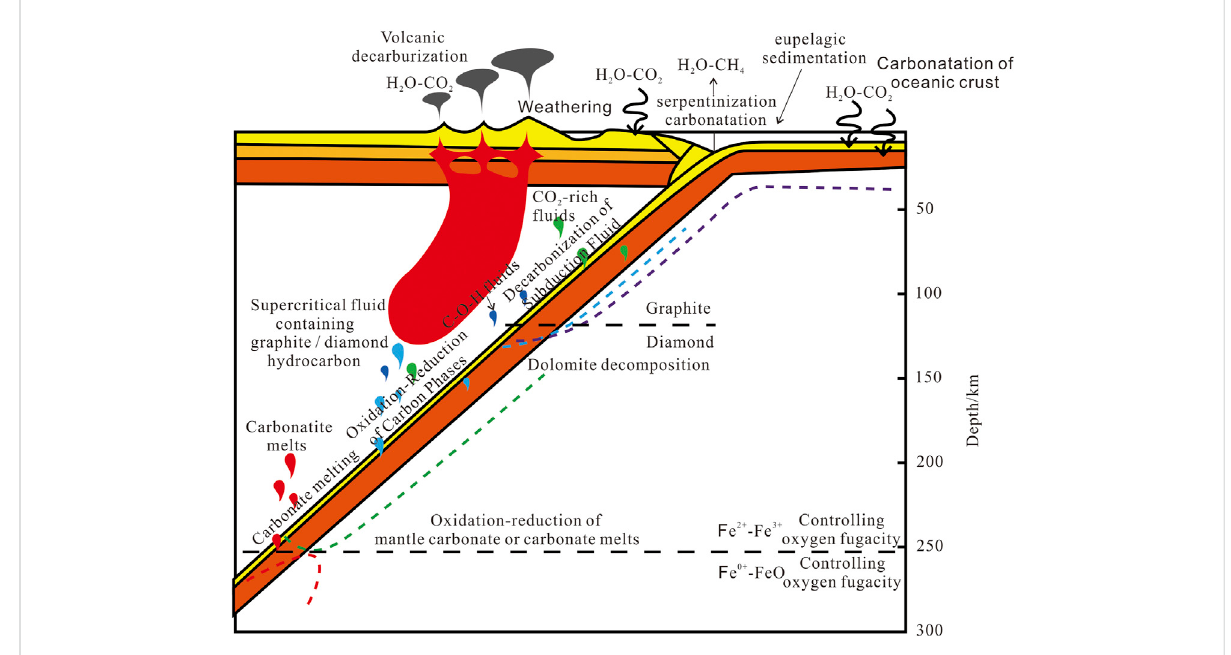
FIGURE 7 Schematic diagram of subduction-belt carbon